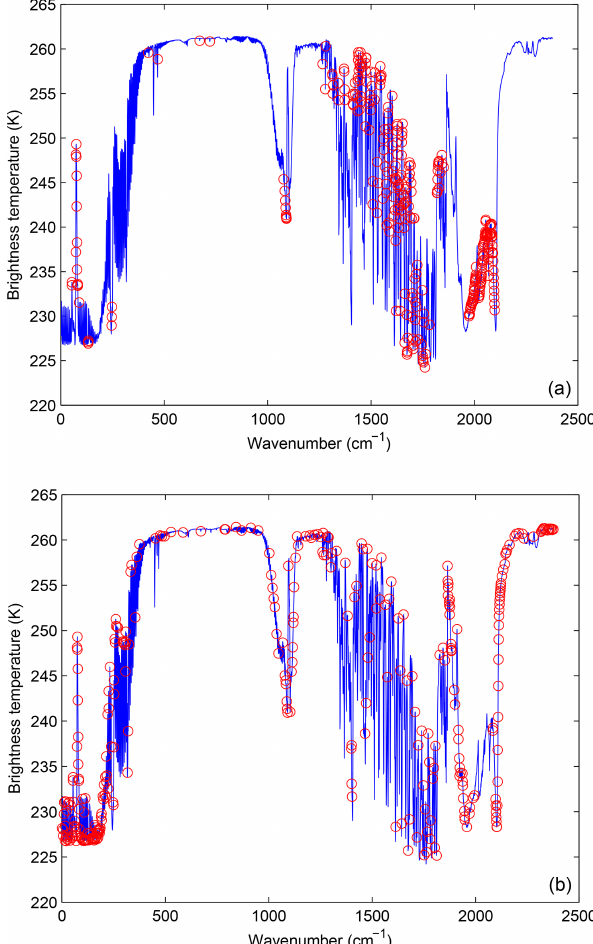
Figure 4. The distribution of different channel selection methods without considering layering in the AIRS brightness temperature spectrum (blue line): (a) 324 channels selected by PCS (red circles) and (b) 324 channels selected by NCS (red